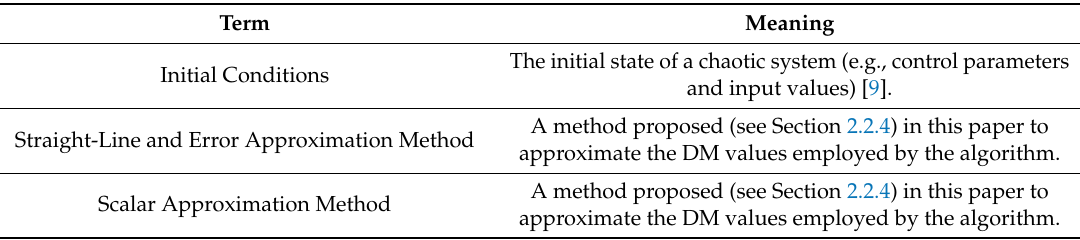
Table A2. List of